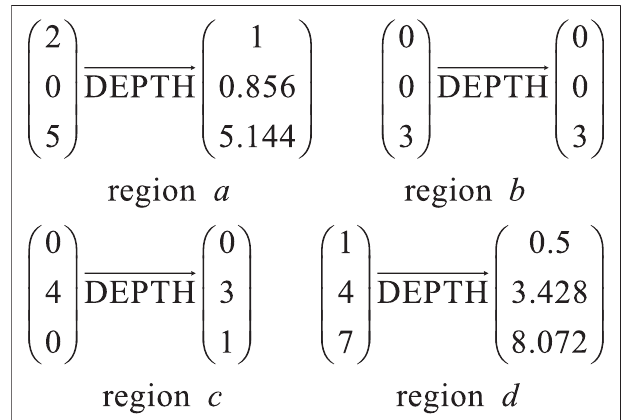
FIGURE 1 | Cell-based method solution process for four regions.